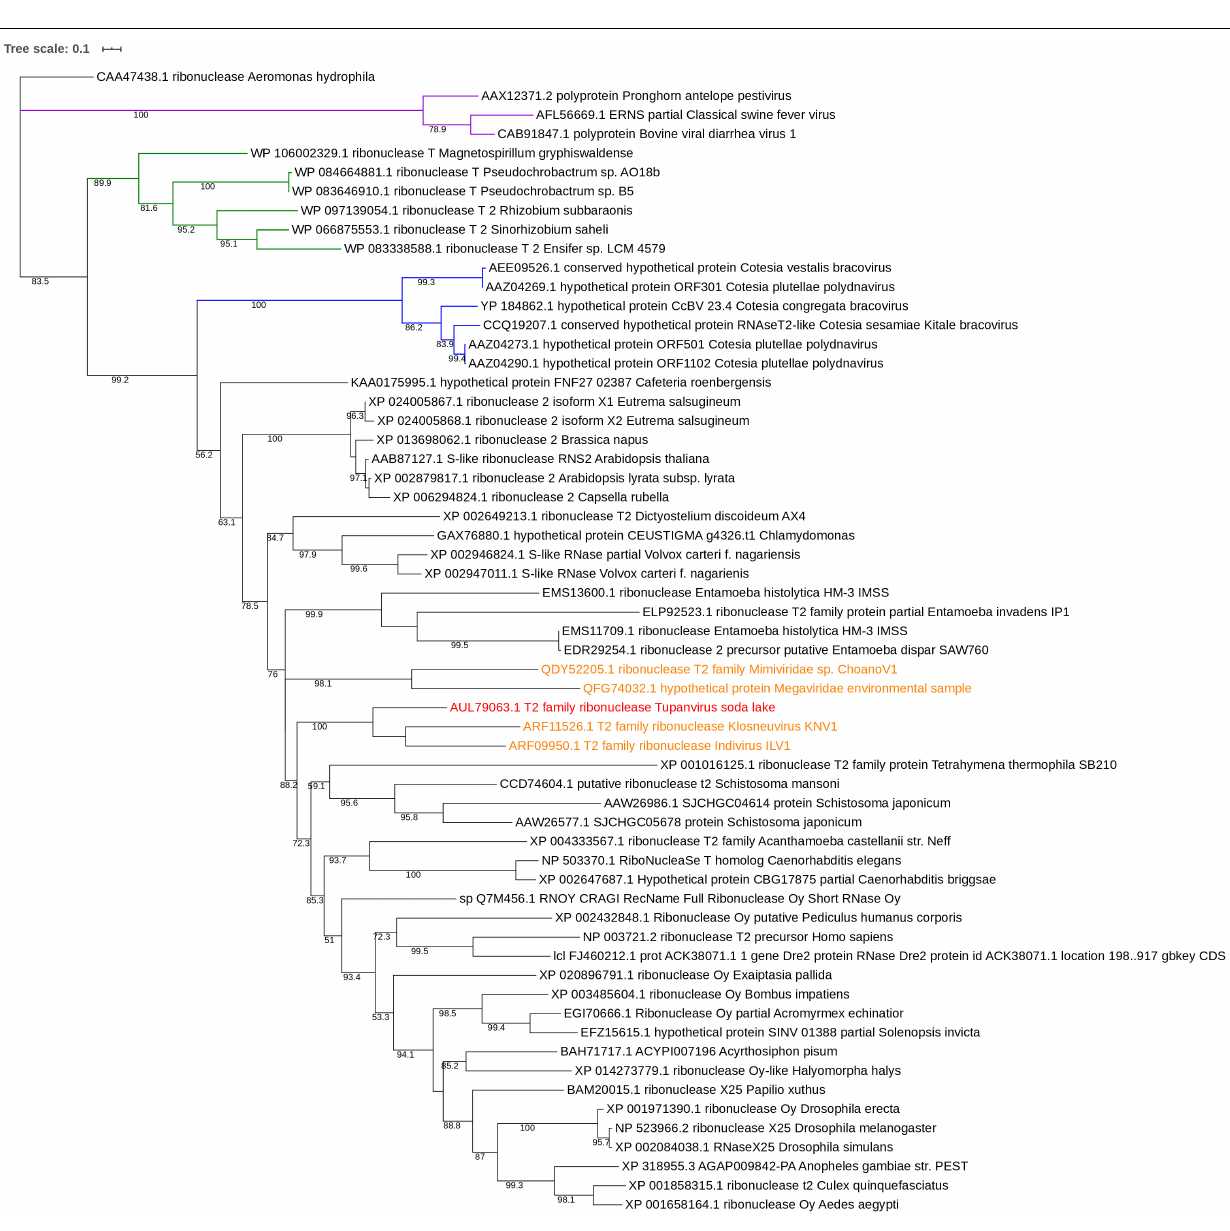
FIGURE 5 | Phylogenetic tree of RNase T2 sequences. The analysis was performed using Maximum Likelihood method (ML) with a JTT substitution matrix in 1000 replicates. Bootstraps below 50 were discarded. The branch labeled in purple corresponds to RNA viruses (pestiviruses), the one in blue to DNA viruses and the one in green to alphaproteobacteria. RNase T2 sequence of TPV-DO is highlighted in red and those of giant viruses in